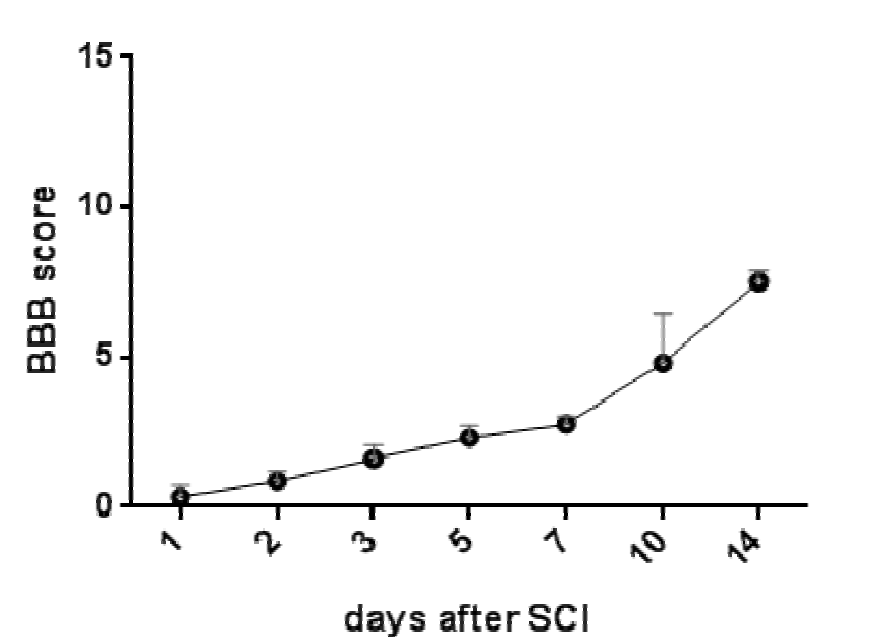
Figure 8. Graph showing locomotor activity of experimental animals after Th9 compression, eval- uated with BBB score Scheme 21. (normal hindlimb movement), were recorded daily for the first three days and thereafter on day 5, 7, 10 and 14. Results are presented as mean ± SD ( n = 5). BBB—Basso–Beattie–Bresnahan score.